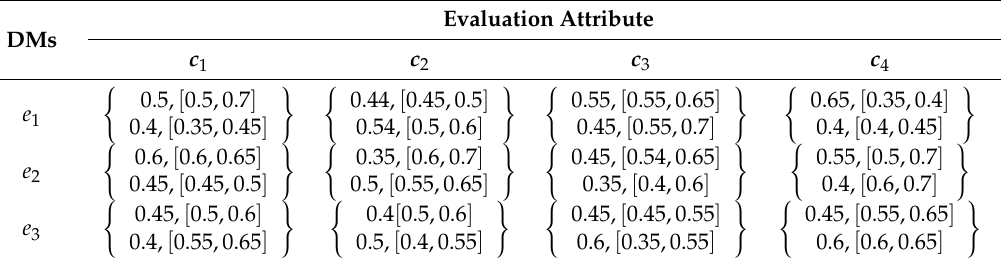
Table 4. Evaluation matrix for attribute weight